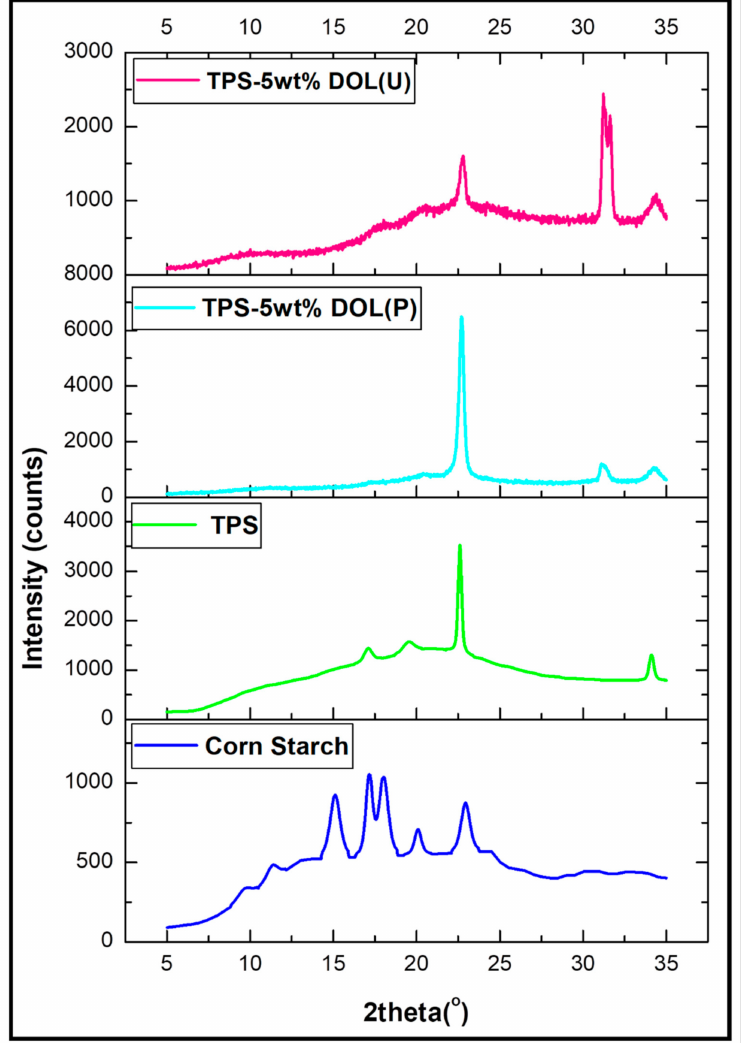
Figure 9. XRD pattern of corn starch, TPS film, and TPS-5wt%DOL (P) and TPS-5wt%DOL (U) biocomposite